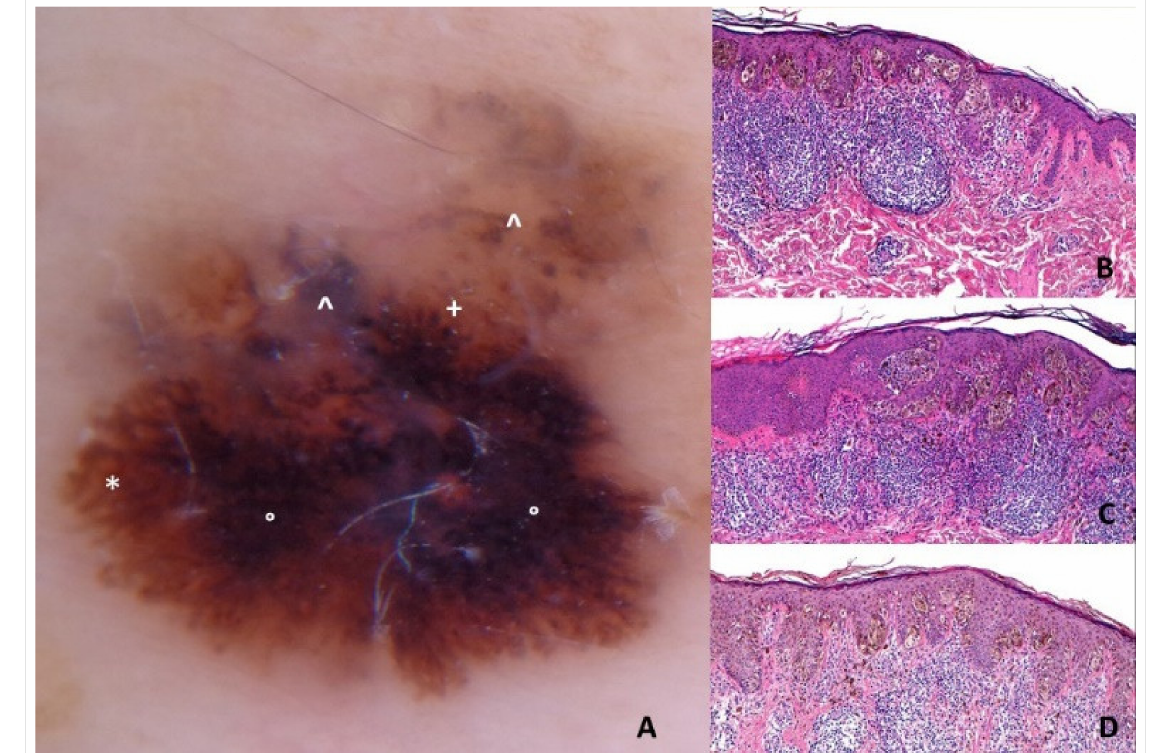
Figure 2. Superficial spreading melanoma (T1a, Breslow 0.53 mm) on the left chest of a 44-y old man. Panel A : Polarized contact dermoscopy (Dermaview ® , Tre T Medical, Camposano, NA, Italy) shows asymmetry, multiple colors, pseudopods (labeled *), atypical network, structureless black areas (labeled ◦ ), structureless blue areas (labeled ˆ), irregular globules (labeled +) and dots. Pseudopods correlate with peripheral, confluent, and heavily pigmented atypical junctional nests of melanocytes (Panel B ; HE: 100 × ). Irregular globules correspond to irregularly large atypical nests of melanocytes at the DEJ (Panel C ; HE: 100 × ) while irregular dots to small atypical nests of melanocytes or irregular clumps of melanin in the epidermis (Panel D ; HE: 100 × ). The structureless black and blue areas are related to the heavy band-like lymphohistiocytic infiltrate with melanophages in the